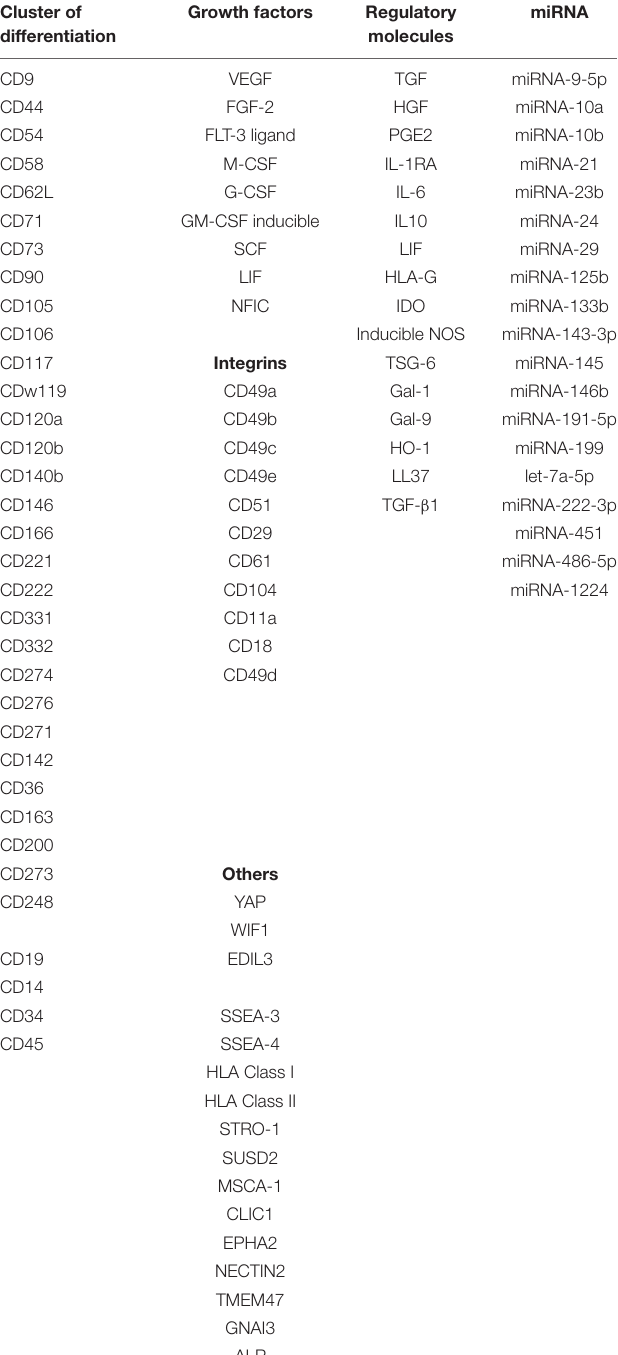
TABLE 2 | Markers, factors, and microRNAs to discriminate MSCs (Lv et al., 2014; Camilleri et al., 2016; Oeller et al., 2018; Pittenger et al., 2019; Brinkhof et al., 2020; Jingqiu et al.,